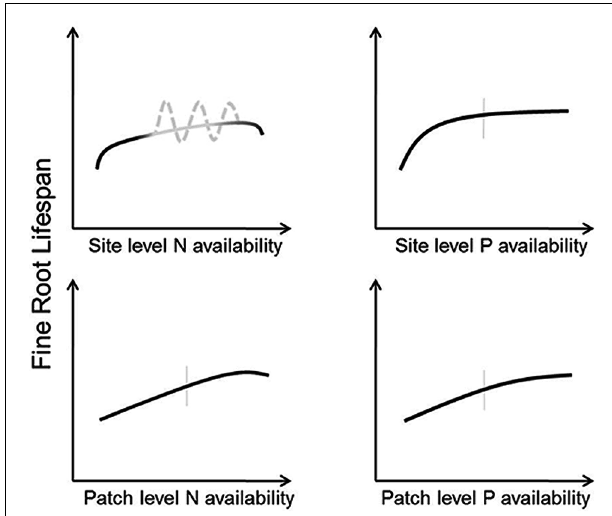
FIGURE 4 | Conceptual models indicating predicted responses of fine root lifespan to altered N (left panels) and P (right panels) at the site level (top panels) and patch level (bottom panels). Vertical gray bars indicate “average” conditions experienced by a given species across its native range.The gray portions of the predicted model for root responses to site level N availability indicate uncertainty regarding site specific effects. Here, the solid line is what might be expected where all conditions of species differences, variable methodology, and soil buffering capacity are held constant whereas the dashed line acknowledges that lifespan could both increase or decrease in response to altered N across a wide range of N